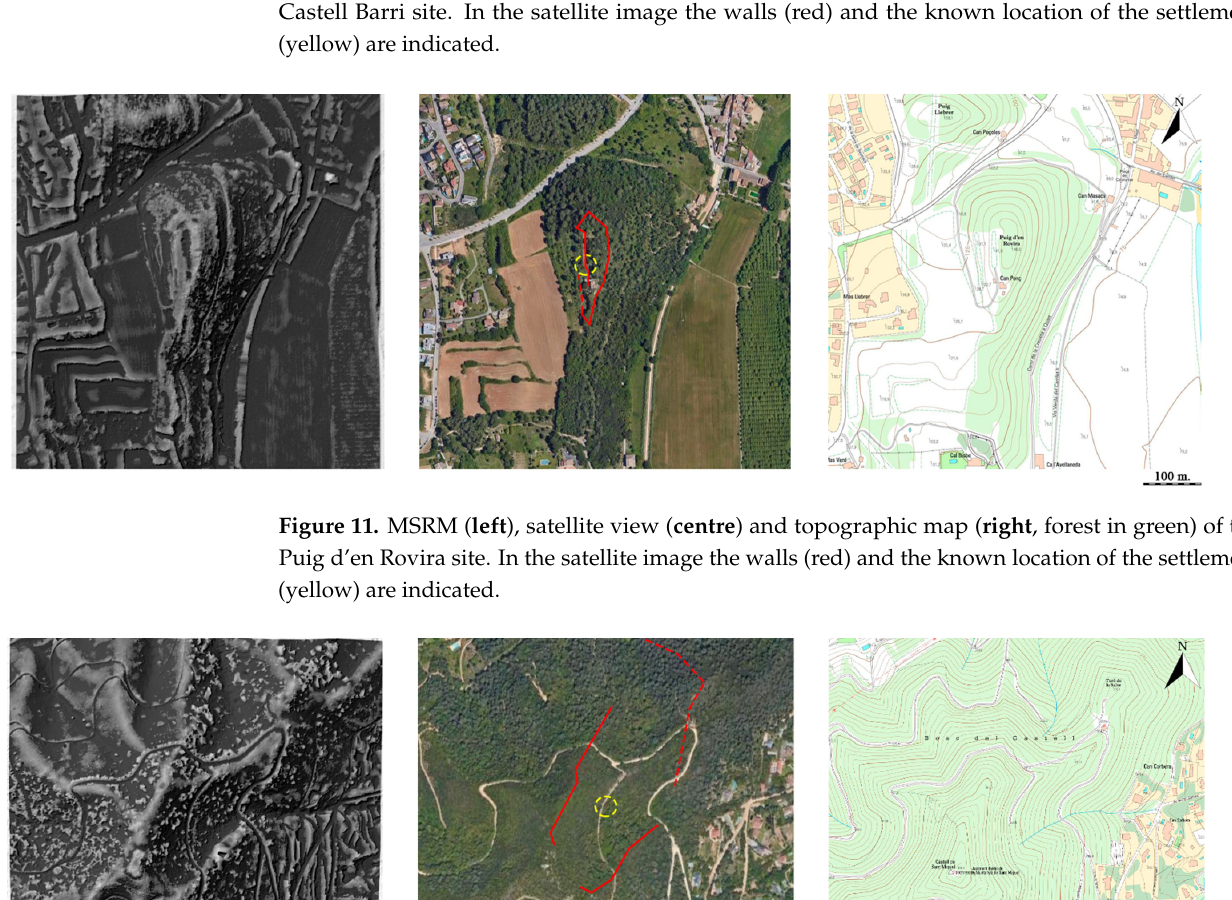
Figure 10. MSRM ( left ), satellite view ( centre ) and topographic map ( right , forest in green) of the Castell Barri site. In the satellite image the walls (red) and the known location of the settlement (yellow) are indicated.